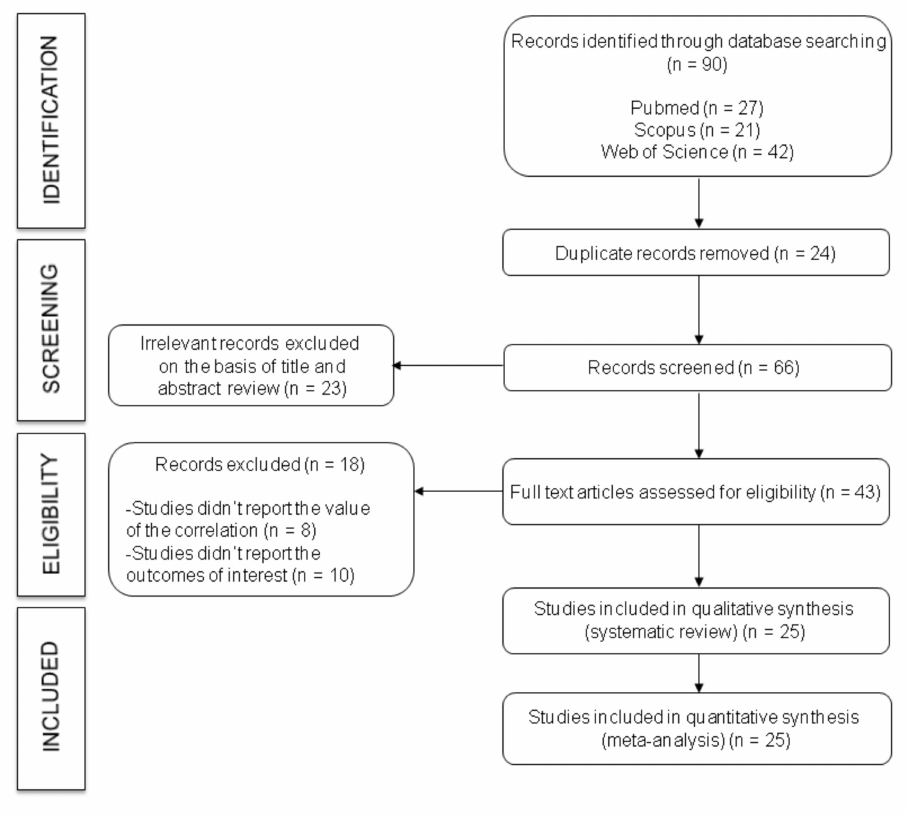
Figure 1. Flowchart: Search